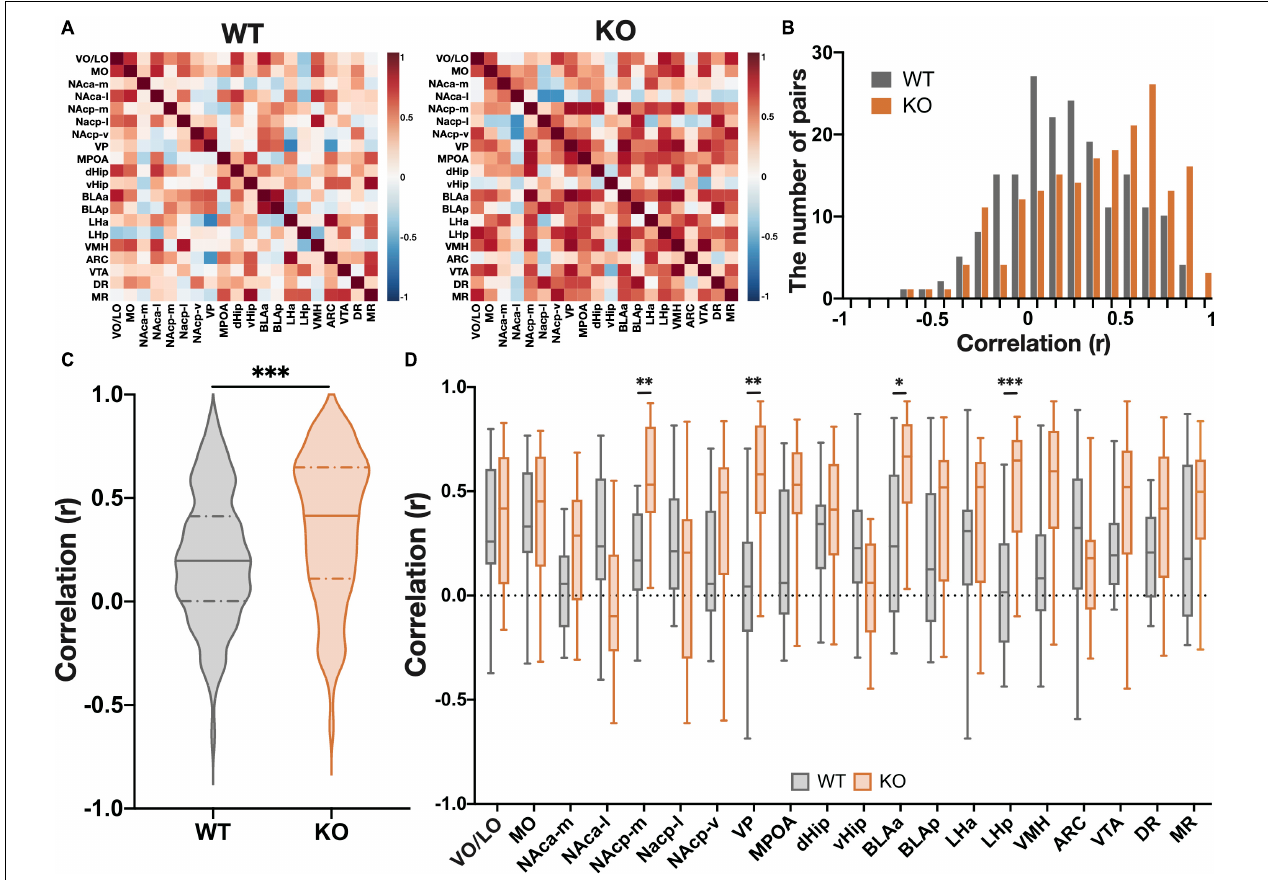
FIGURE 4 | KPNA3 KO mice show increased functional connectivity during the performance in the progressive ratio schedule test when compared to WT mice. (A) Heat map of all interregional correlation coefficients in WT and KO groups. (B) Histogram of all interregional correlation coefficients. (C) Violin plot of all correlation coefficients. Solid line: median, dashed line: quartiles. Mann Whitney u test. (D) Correlation coefficients of each region. Data represent the median, quartiles, maximum, and minimum, Mann Whitney u test and Bonferroni correction, ∗ p < 0.05, ∗∗ p < 0.01, ∗∗∗ p < 0.001. ARC, arcuate nucleus; BLA, basolateral amygdala; dHip, dorsal hippocampus; DR, dorsal raphe nucleus; LH, lateral hypothalamus; MO, medial orbital area; MPOA, medial preoptic area; MR, median raphe nucleus; NAc, nucleus accumbens (a, anterior; p , posterior; m, medial; l, lateral; v, ventral), vHip, ventral hippocampus; VMH, ventromedial hypothalamic nucleus; VO/LO, ventral and lateral orbital area; VP, ventral pallidum; VTA, ventral tegmental